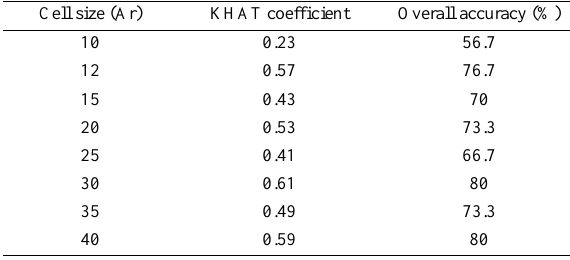
Table 1. The analyses of final canopy density maps.